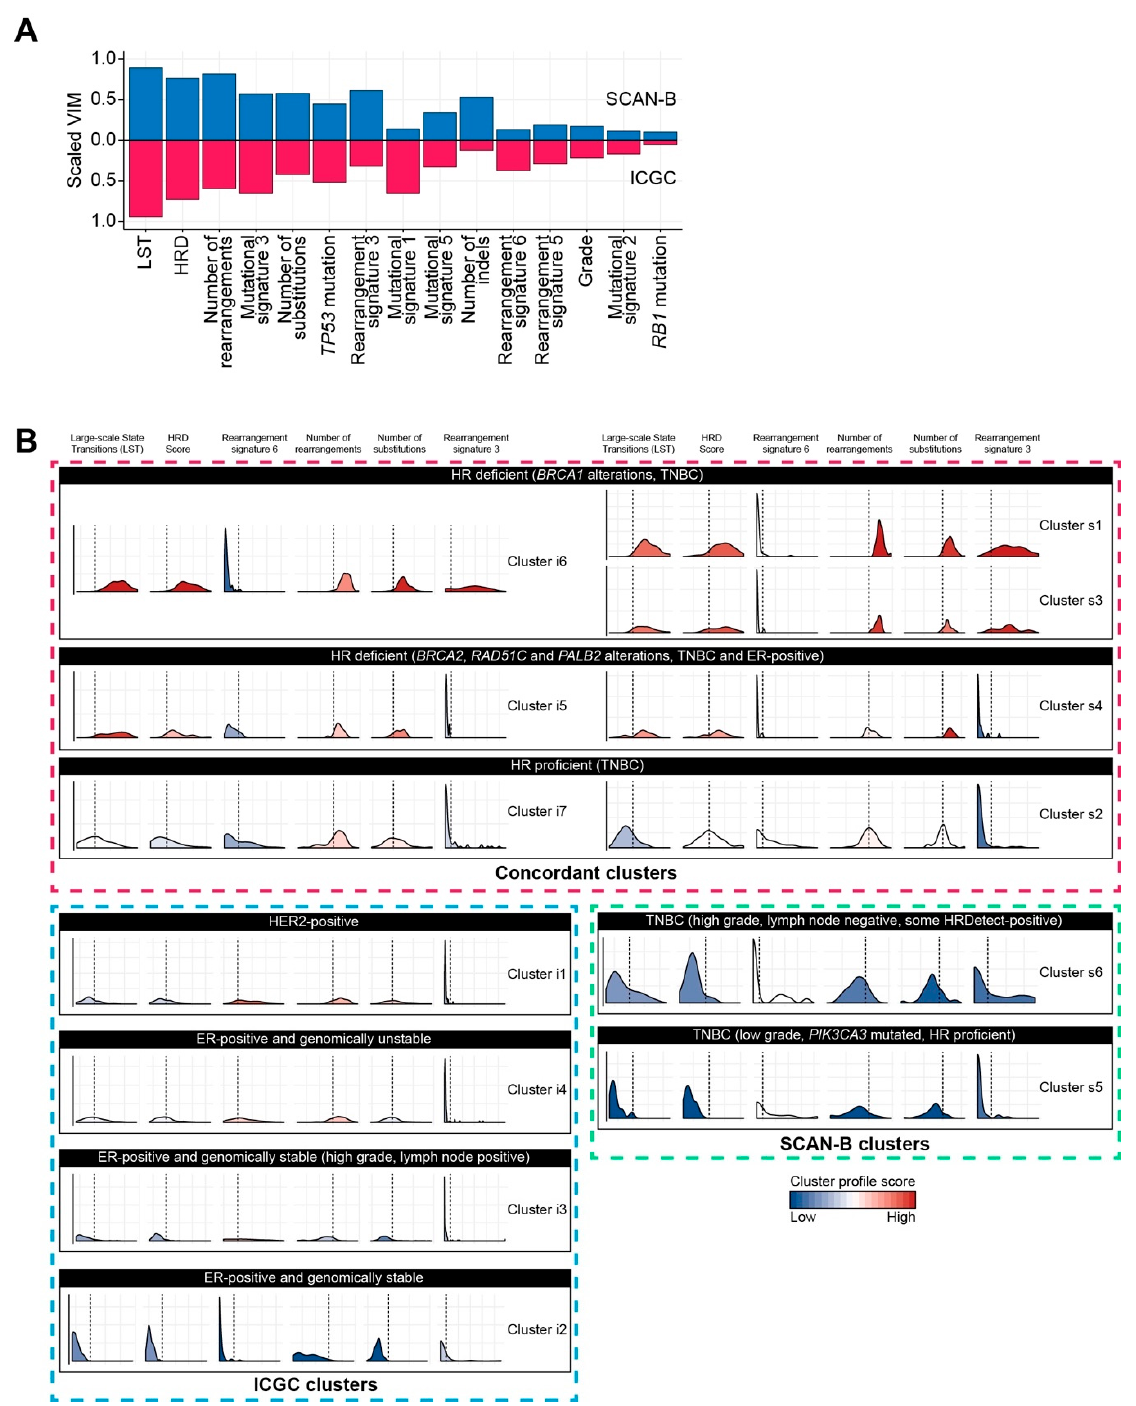
Figure 2. Cluster profile comparison of mixed-type high-dimensional data in ICGC and SCAN-B. ( A ) Barplot of scaled VIMs (y-axis) in SCAN-B (blue) and ICGC (red). In both datasets, condCIF was performed on all available features. The VIMs were scaled and ordered by rank in both datasets. ( B ) Cluster profile scores comparing SCAN-B (cluster s1 to s6) and ICGC (cluster i1 to i7) derived clusters. The distribution of large-scale state transition (LST), homologous recombination deficiency (HRD) score, rearrangement signature 6, number of rearrangements, number of substitutions and rearrangement signature 3 are shown, with the dashed line indicating the median. The colour of the density indicates the median profile score for that cluster, with a red indicating a relative high prevalence of this